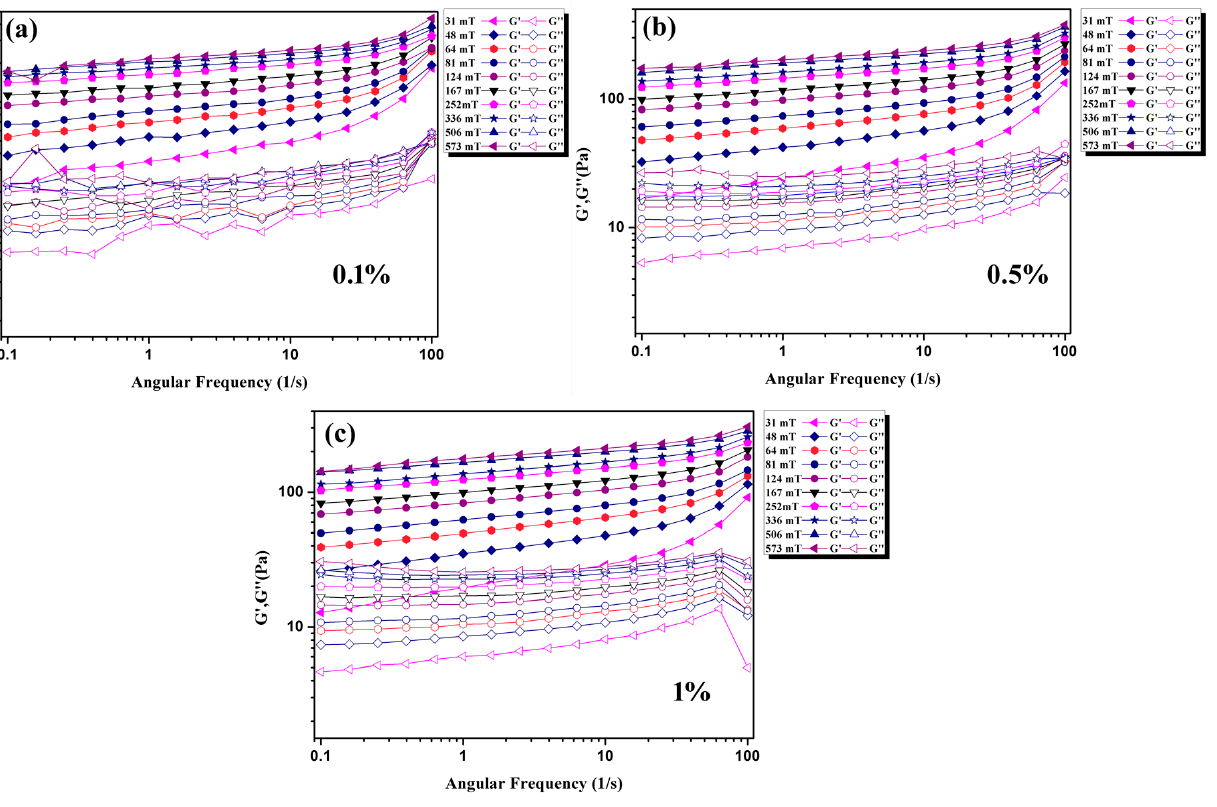
Figure 9. The storage modulus G’ and loss modulus G” as a function of frequency at 0.1% ( a ), 0.5% ( b ), and 1% strain ( c ).